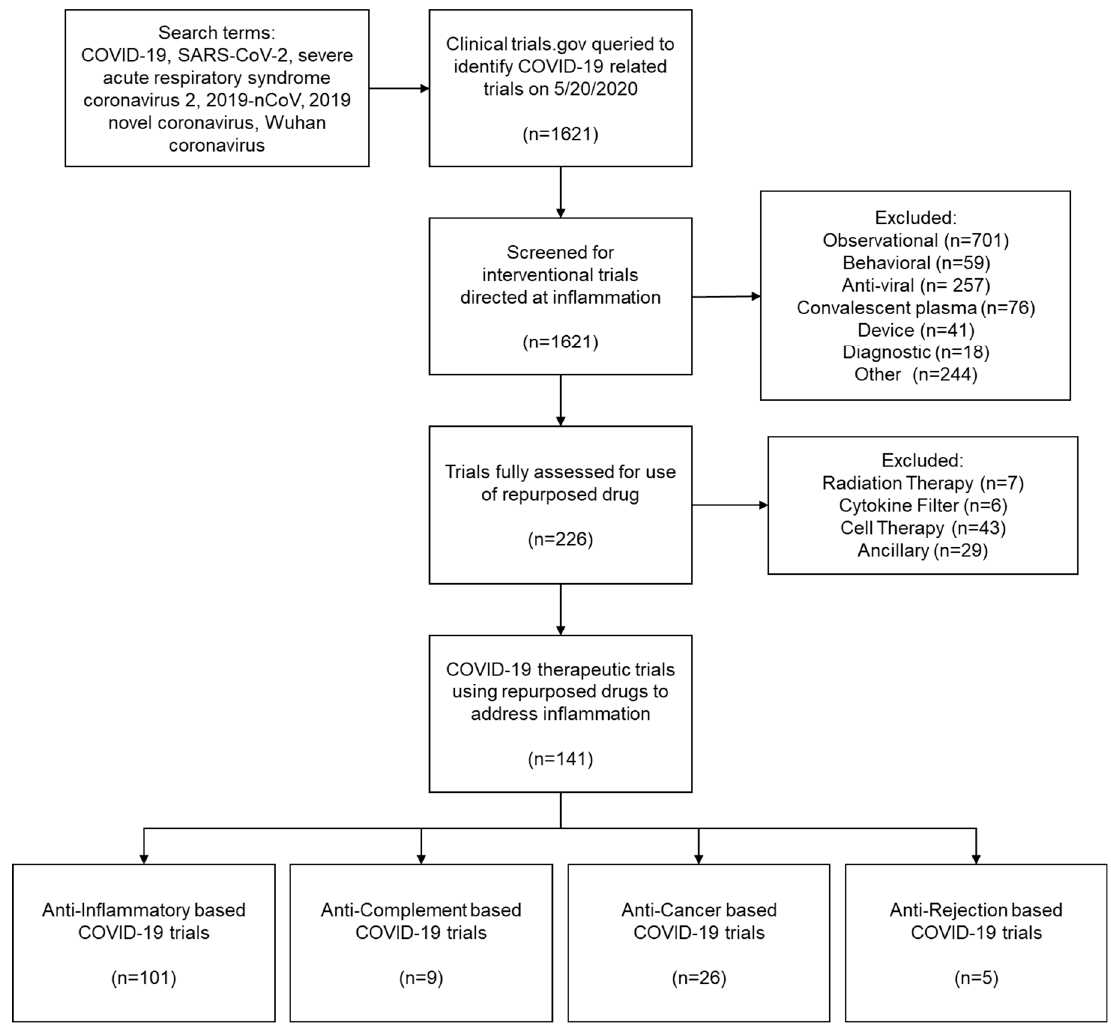
Figure 1. PRISMA flow diagram of systematic COVID ‐ 19 clinical trials analysis for COVID ‐ 19 therapeutic trials using repurposed drugs to address inflammation.